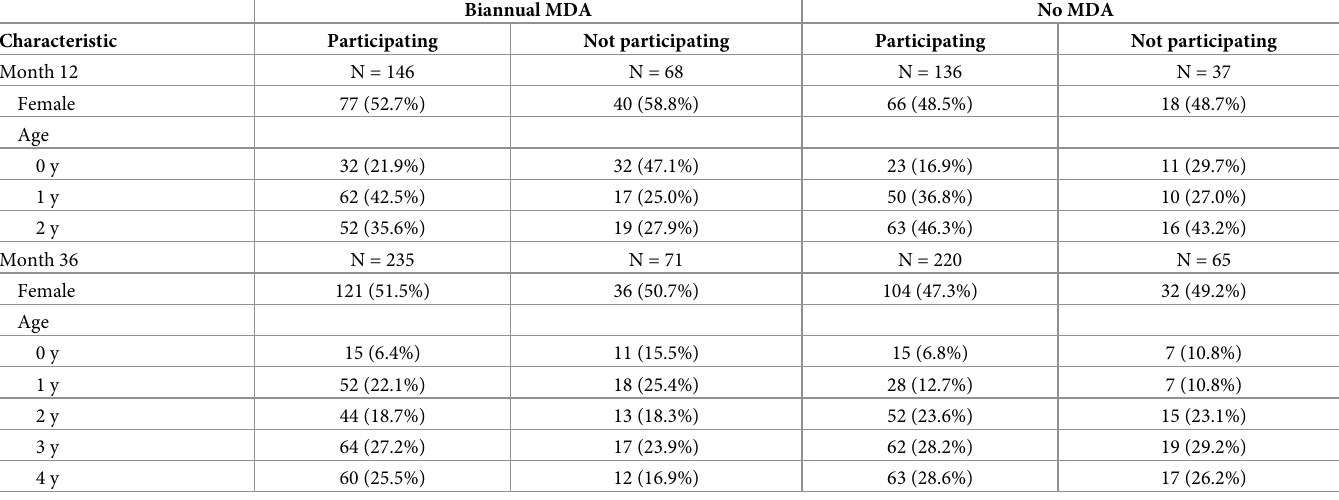
Table 3. Characteristics of study participants at each monitoring visit, stratified by participation